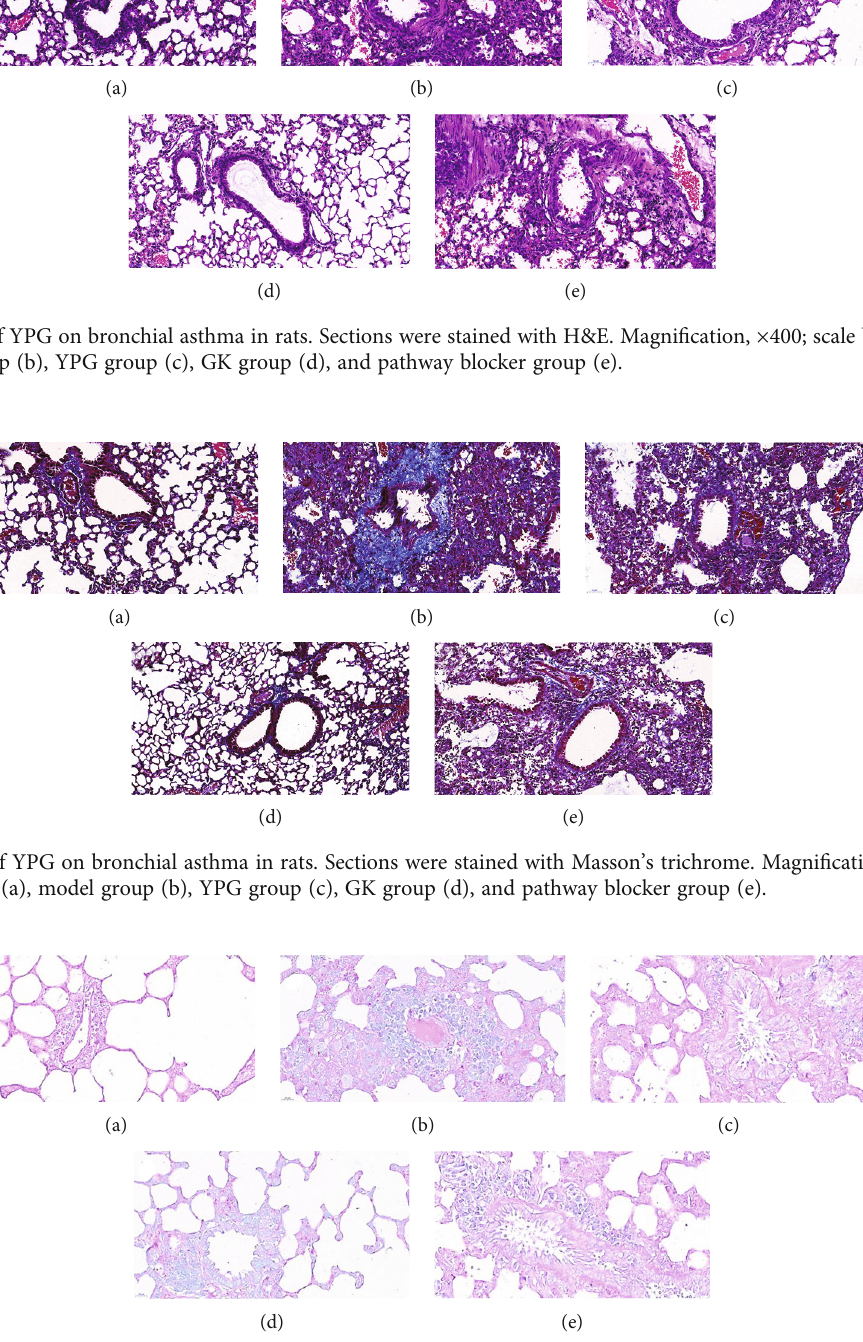
Figure 5: The e ff ect of YPG on bronchial asthma in rats. Sections were stained with AB-PAS. Magni fi cation, × 400; scale bars, 50 μ m. Normal group (a), model group (b), YPG group (c), GK group (d), and pathway blocker group